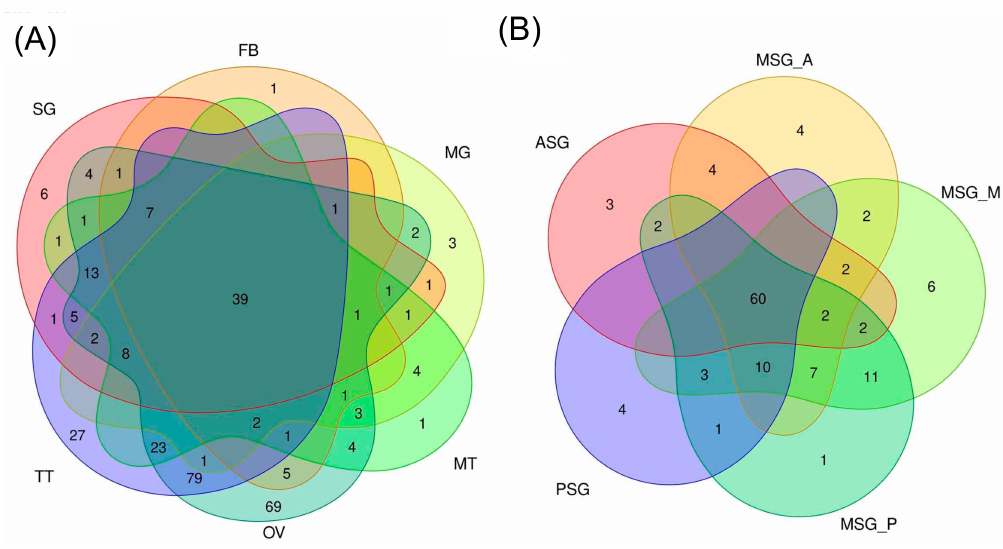
Figure 10. Venn diagrams showing the number of transcriptional factor (TF) transcripts with a tpm value > 5 ( A ) in each tissue and ( B ) in the silk gland